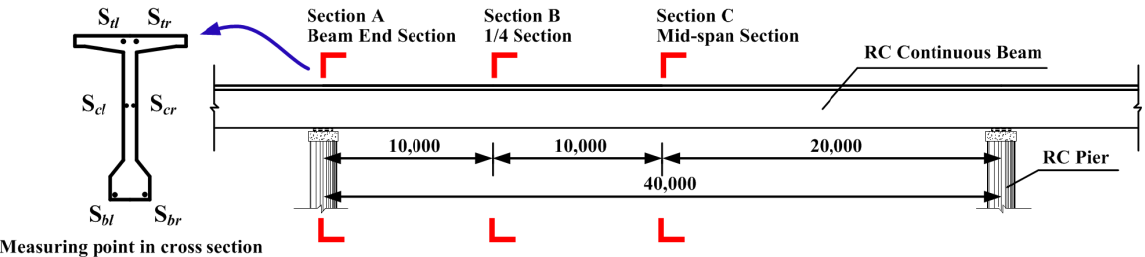
Figure 2. Cross-sections and test points chosen for the field test.